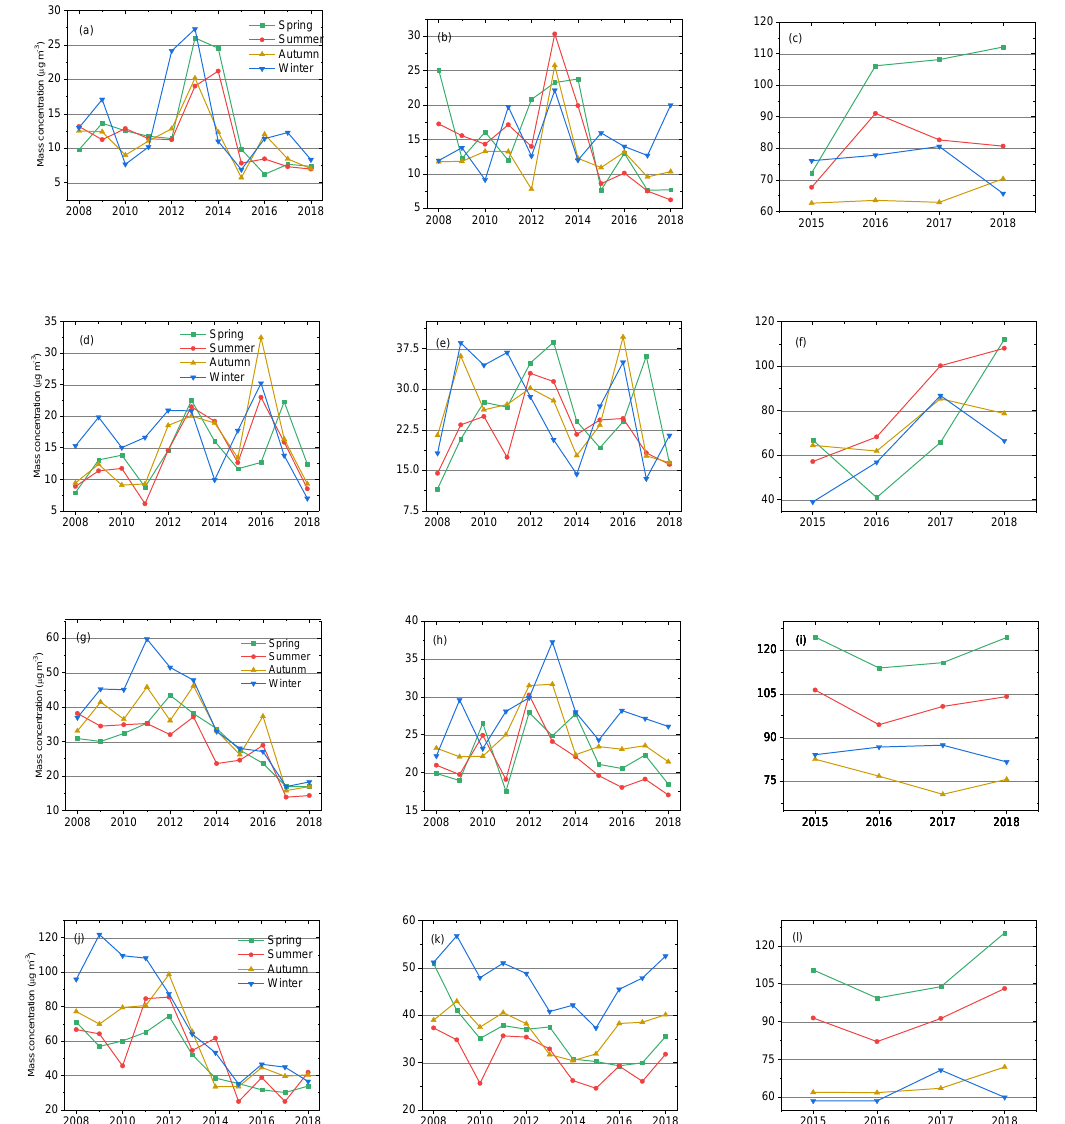
Figure 4. Annual variations of three air pollutants in different seasons: ( a ) SO 2 , ( b ) NO 2 , and ( c ) O 3 in Aba; ( d ) SO 2 , ( e ) NO 2 , and ( f ) O 3 in Ganzi; ( g ) SO 2 , ( h ) NO 2 , and ( i ) O 3 in Liangshan; ( j ) SO 2 , ( k ) NO 2 , and ( l ) O 3 in Panzhihua.